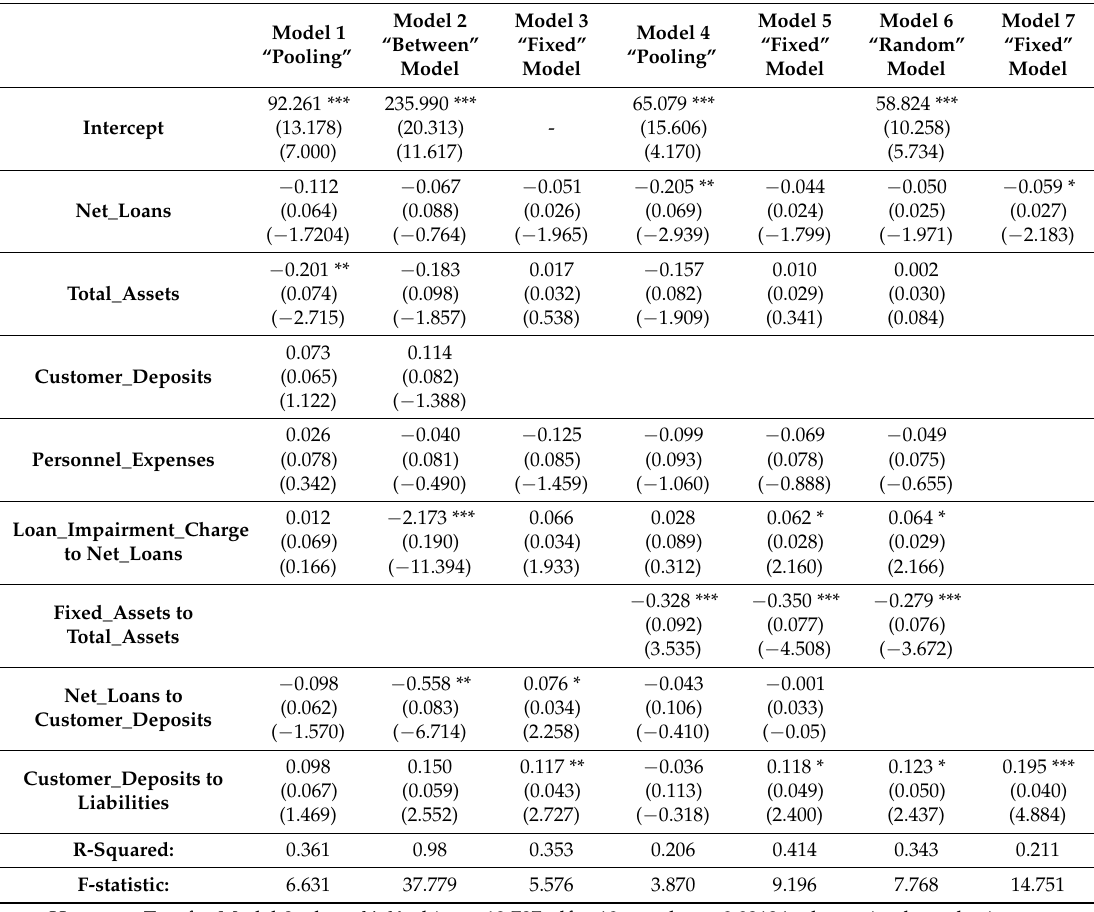
Table 9. Results of panel regression for the whole group of the Balkan